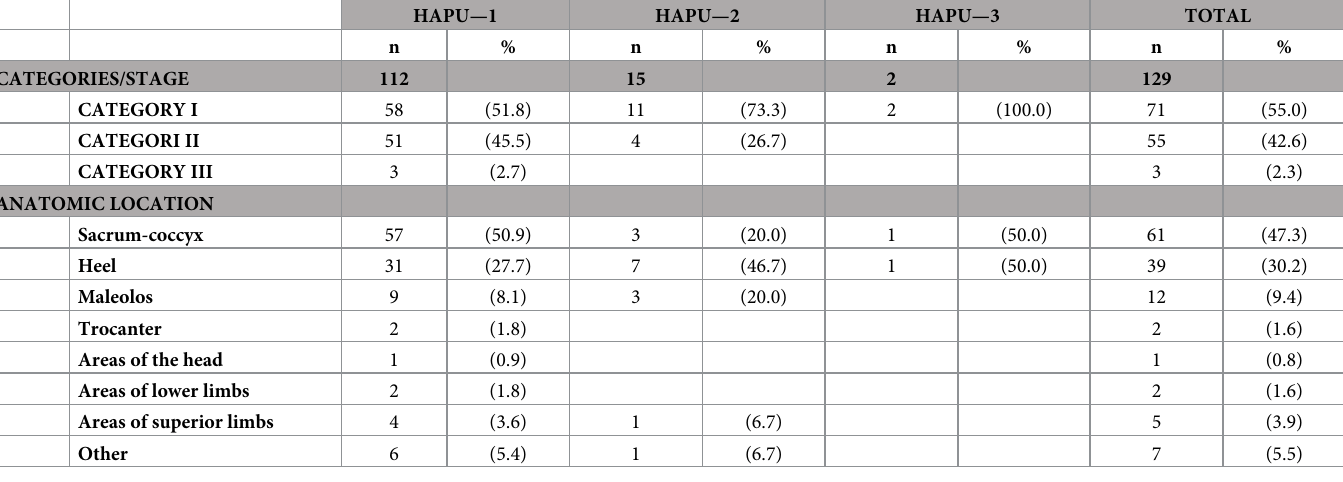
Table 3. General description of HAPU, frequency by categories and anatomical